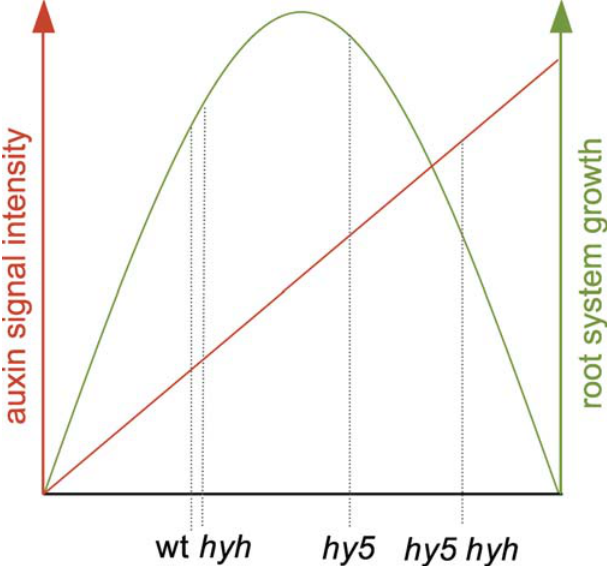
Figure 7. Correlation of Root System Growth and Auxin Signaling Graphical presentation of a model explaining the opposite root system phenotypes of hy5 and hy5 hyh mutants. The strength of (constitutive) auxin signaling in the respective genotype determines the extent of root system growth. Root system growth is maximal at a certain optimum